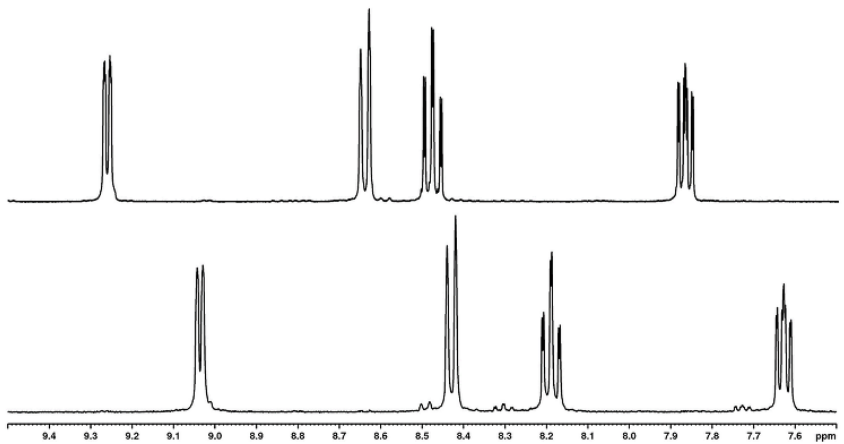
Figure 2. Aromatic regions of the 1 H-NMR spectra of fac -[Re(CO) 2 (NO)(bpy)Br] + ( 1 , top) and fac - [Re I (CO) 3 (bpy)Br] + . Both spectra recorded in CD 3 CN. fac -[Re I (CO) + . Both spectra recorded in CD 3 (bpy)Br] 3